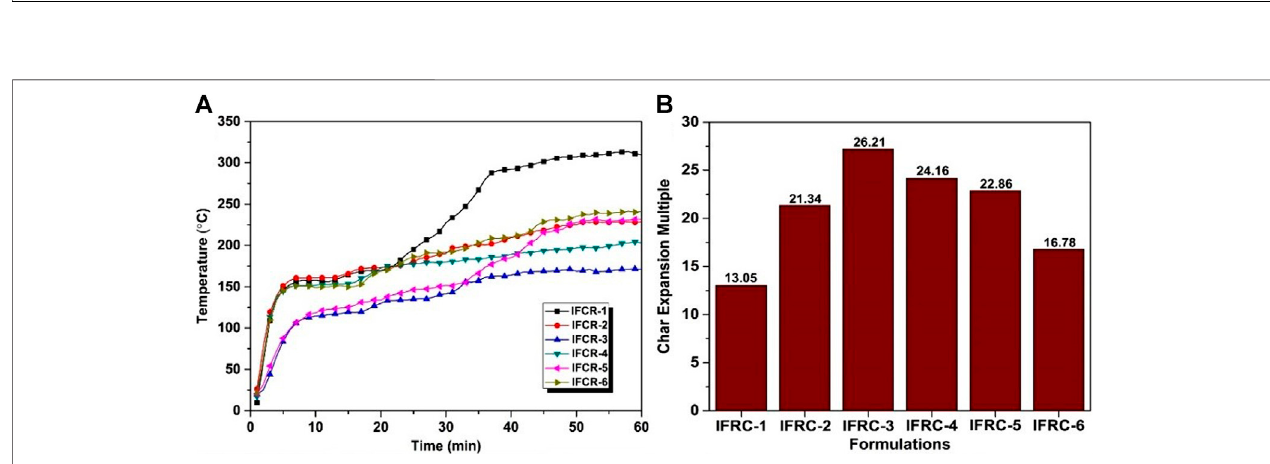
FIGURE 5 | (A) Backside temperatures of coatings and (B) char expansion degrees of chars (Wang et al., 2020a).